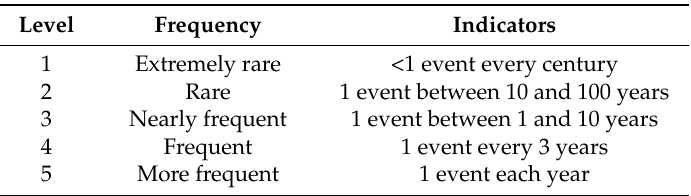
Table 2. level of frequency of natural